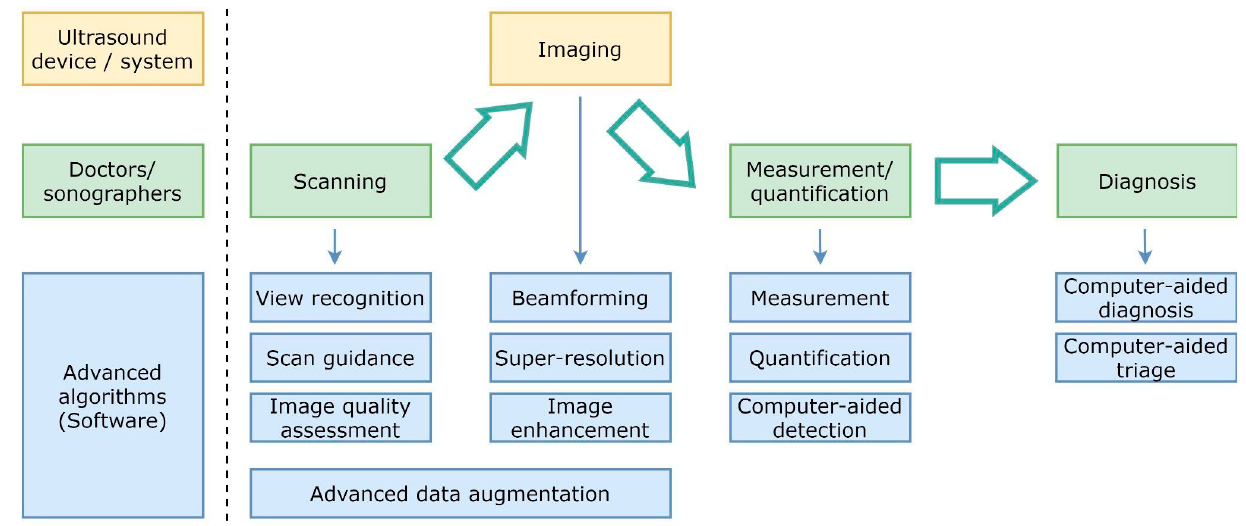
Figure 2. Simpli fi ed diagram of the diagnostic work fl ow with computer-assisted ultrasound de- Figure 2. Simplified diagram of the diagnostic workflow with computer-assisted ultrasound vices.